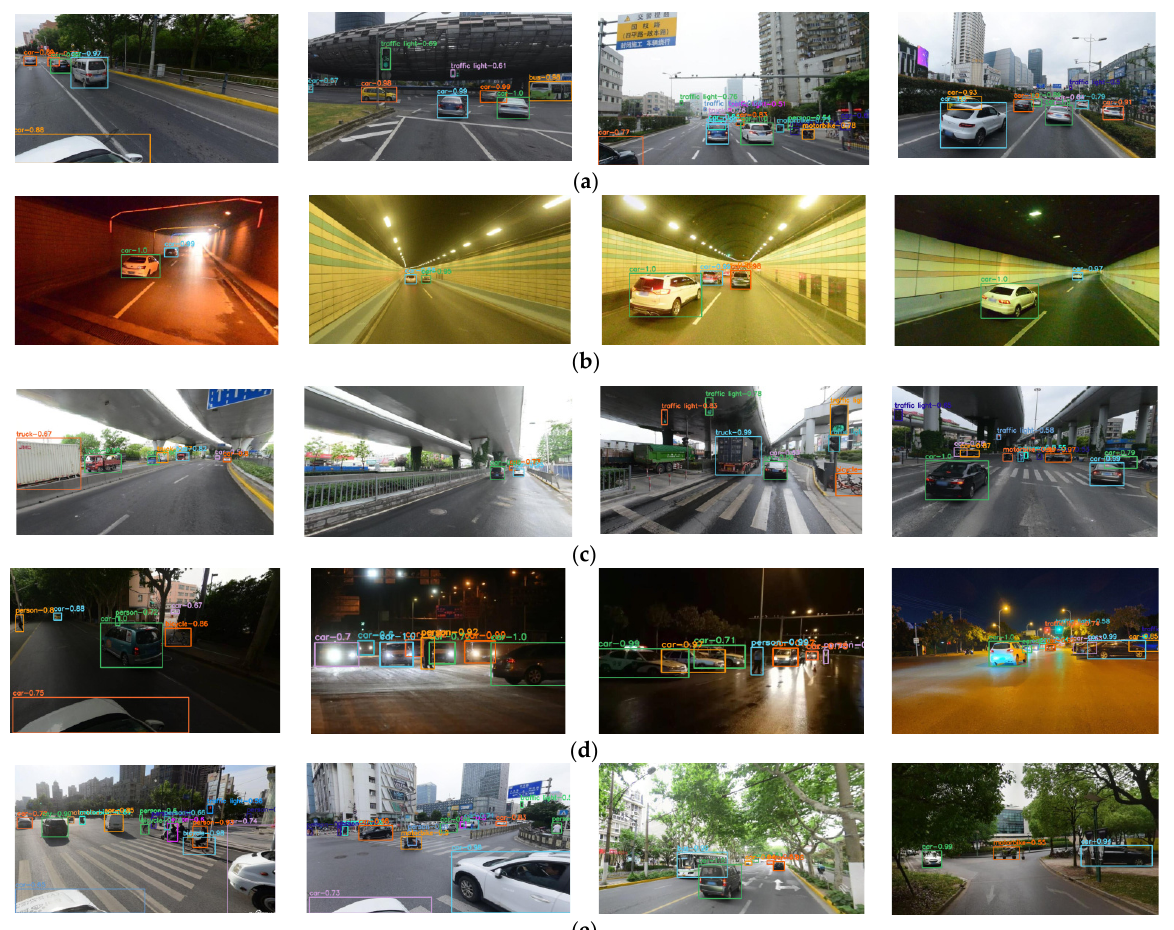
Figure 19. Effect diagram of actual test of RES-YOLO network in local data. ( a ) Urban road environment; ( b ) Tunnel road environment; ( c ) Skyway environment; ( d ) Night dark environment; ( e ) Trees, pedestrians, and other disturbing environments.